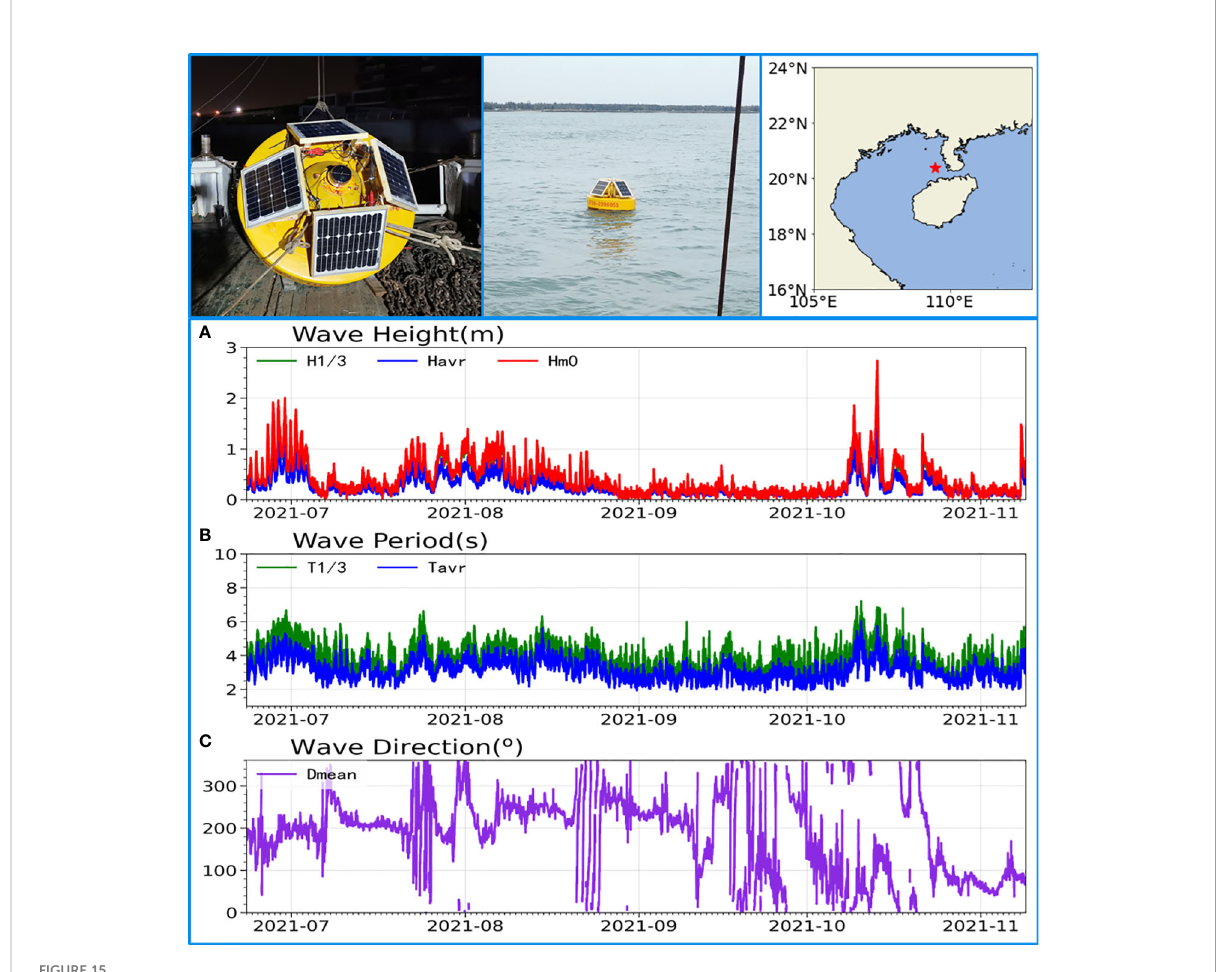
FIGURE 15 Wave observation in